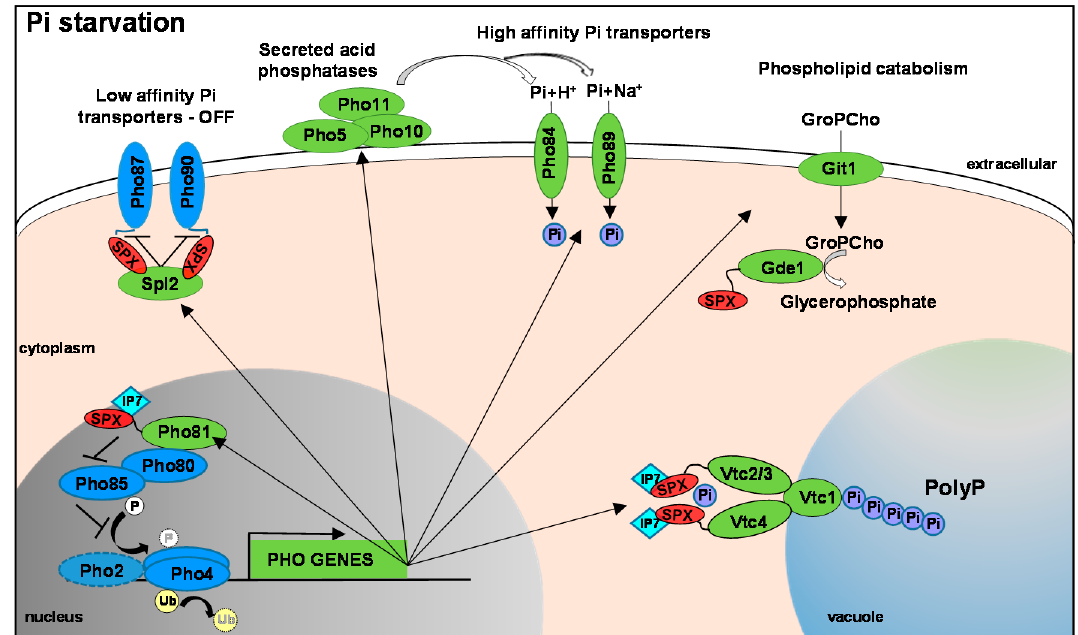
Figure 1. The PHO Regulon. This is based on the well characterised system in S. cerevisiae that is largely conserved in human fungal pathogens. In response to phosphate limitation the Pho4 transcription factor (TF) is dephosphorylated (and possibly deubiquitinylated). This allows for Pho4 nuclear accumulation